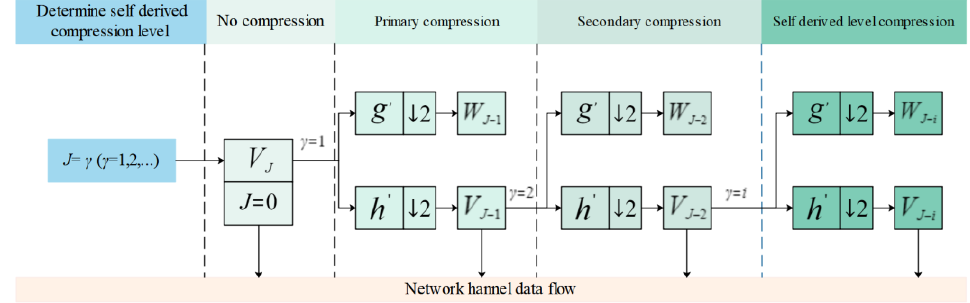
Figure 3. Multi-level decomposition process of self-derived wavelet compression data information.